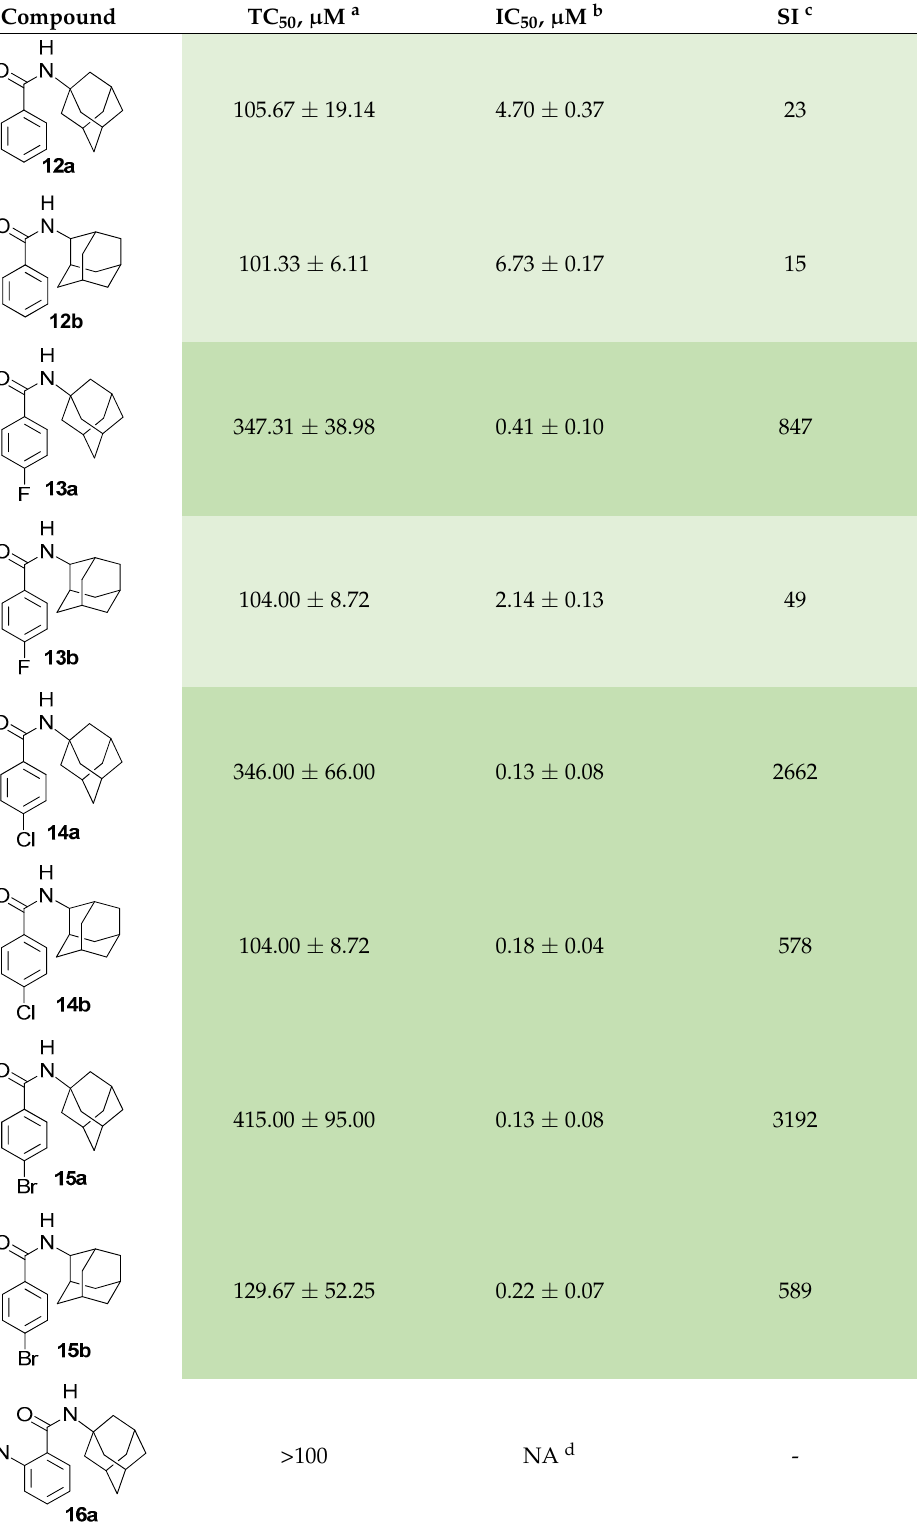
Table 1. TC 50 , IC 50 , and SI values for amides 12a , b – 18a , b and bromantane.